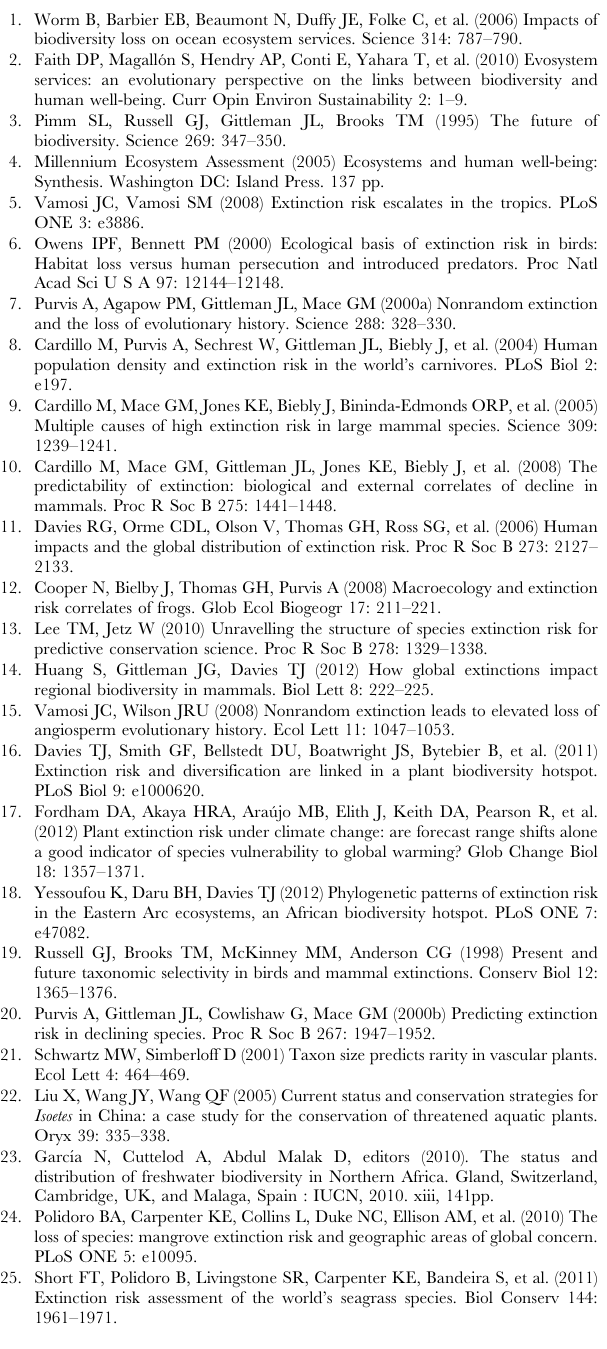
Table S1 Voucher table with GenBank accession num- bers for the gene regions used in phylogeny reconstruc- tion, IUCN categories, extinction probabilities, global decline, life history traits (maximum plant height and propagule size), and human pressure for the mangrove species included in our